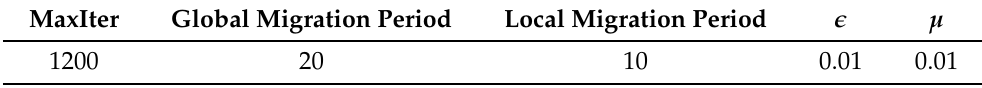
Table 3. Free parameters values of the proposed method.